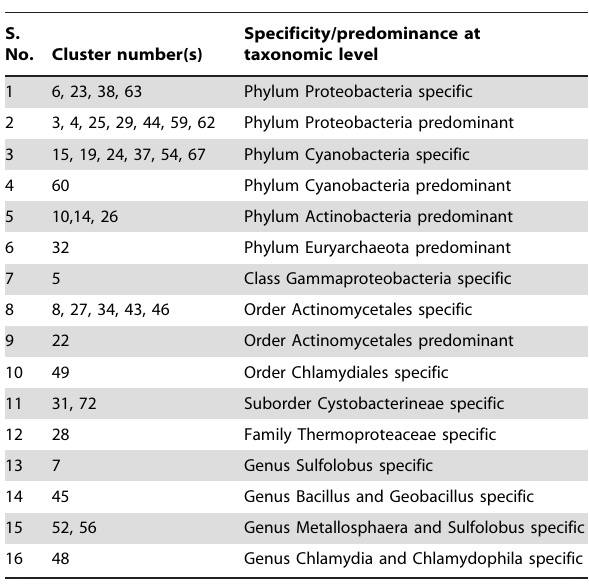
Table 1. Brief description of 38 subfamilies of prokaryotic Ser/Thr kinases which show specificity/predominance at certain taxonomic